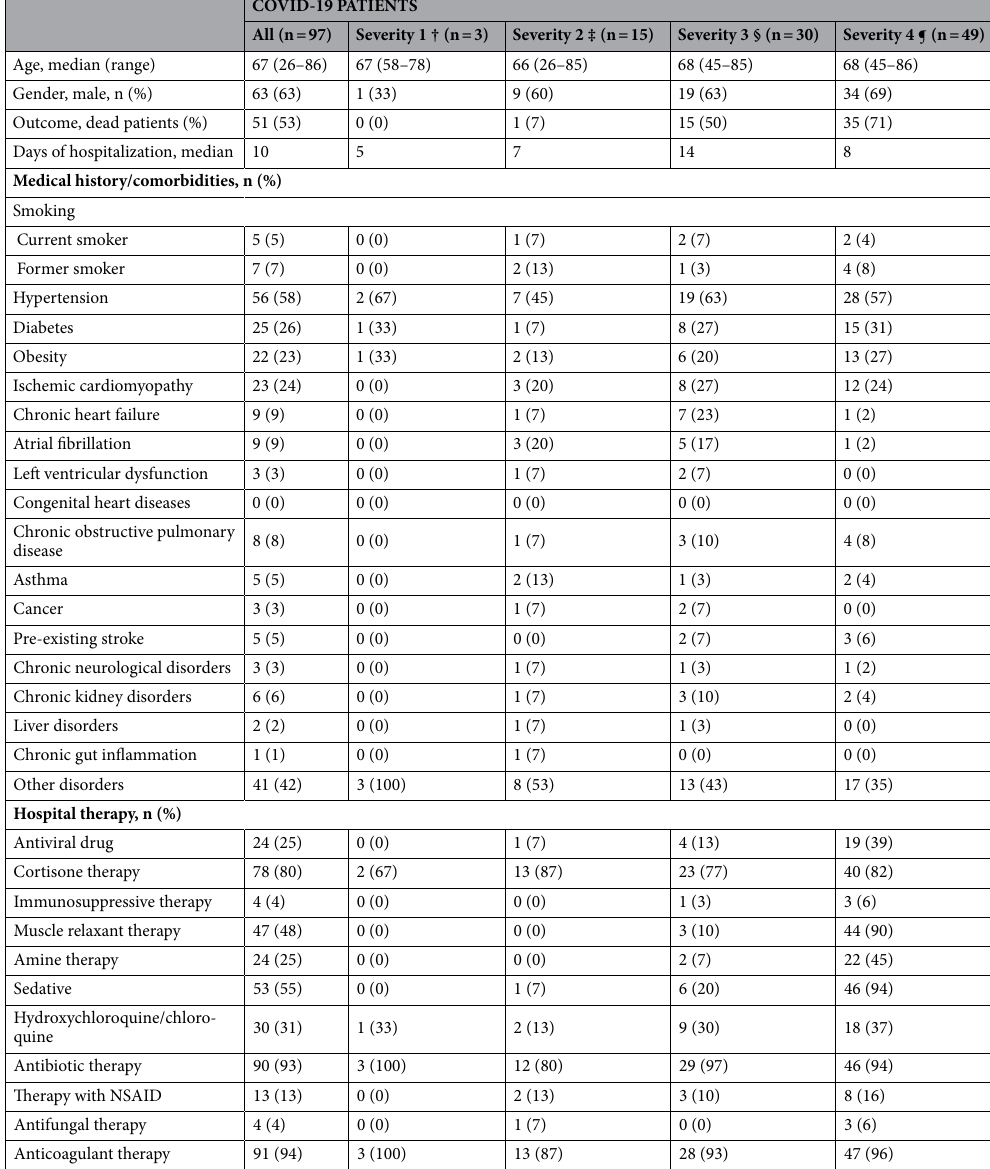
Table 1. Characteristics of the COVID-19 patients hospitalized at PSD. † Severity 1: patients not requiring oxygen therapy; ‡ Severity 2: patients requiring oxygen therapy; § Severity 3: patients requiring CPAP therapy; ¶ Severity 4: ICU-admitted patients with endotracheal intubation